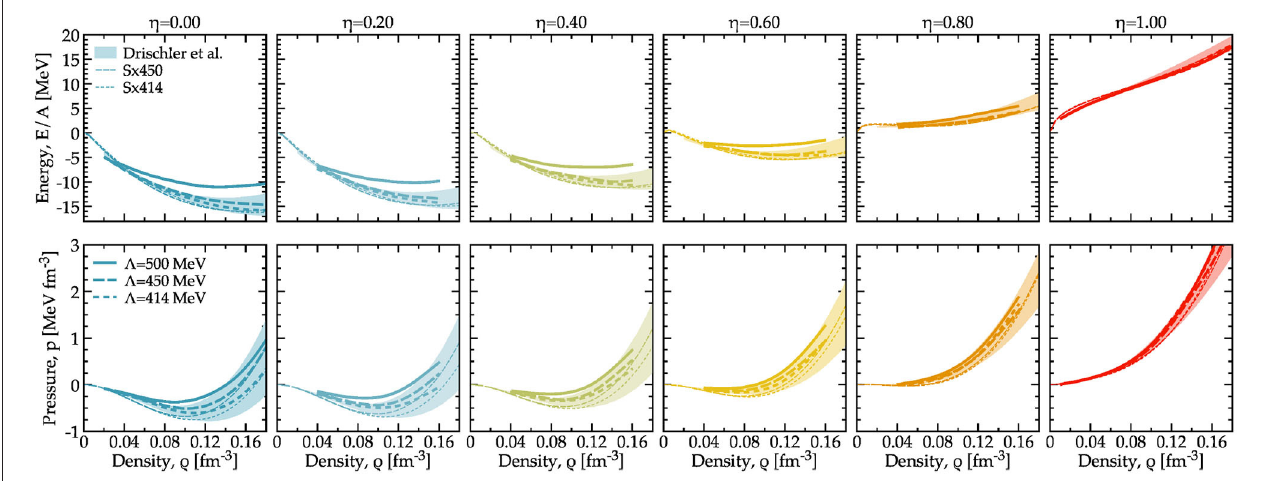
FIGURE 12 | Energy per particle (top) and pressure (bottom) as a function of density for different isospin asymmetries. Results have been extrapolated to zero temperature. The thin lines have been generated from Skyrme functionals fitted to second-order calculations with the same underlying NN forces by Lim and Holt [120]. The bands are obtained from fits to many-body perturbation theory calculations by Drischler et al. [73].